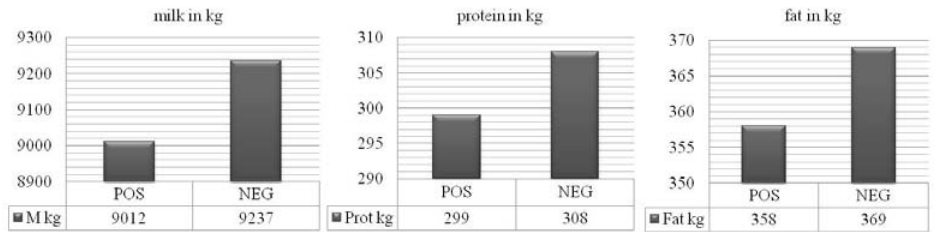
Figure 1 LS means for positive and negative faecal culture tested cows (n=9367) for the average 305-day milk, protein and fat in kg Calving interval